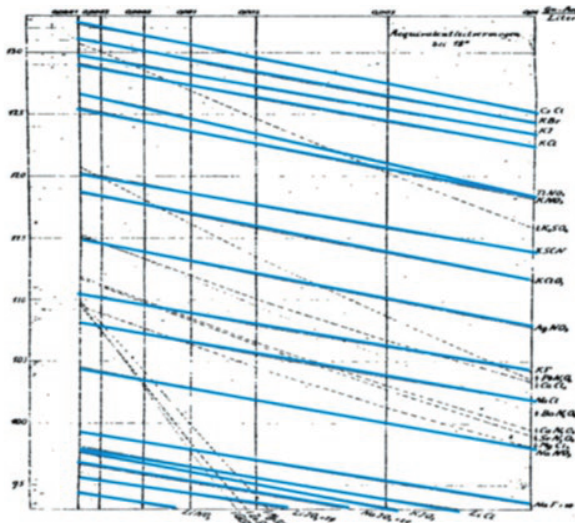
Figure 7. Dependence of the equivalent conductivity on the square root of the equivalent concentration according to the 2nd Kohl- rausch law, the square-root law (termed “Quadratwurzel Gesetz” by Kohlrausch) for 1st class electrolytes. The straight lines of electro- lytes with the same stoichiometry run parallel, most pronouncedly for salts with 1:1 single-charged ions. They are highlighted in blue. Since the letters in the illustrations of that time were mostly very small and hardly legible, we give the formulas of these salts in the order from top to bottom as follows: CsC l; KBr ; KCl ; KNO 3 ; KSCN ; KClO 3 ; AgNO 3 ; NaCl ; NaF ; LiCl ; KJO 3 ; NaJO 3 ; LiJO 3 ; LiNO 3 . Ordi- nate, equ. conc.; abscissa, equ. conductivity. Modified, from [135]